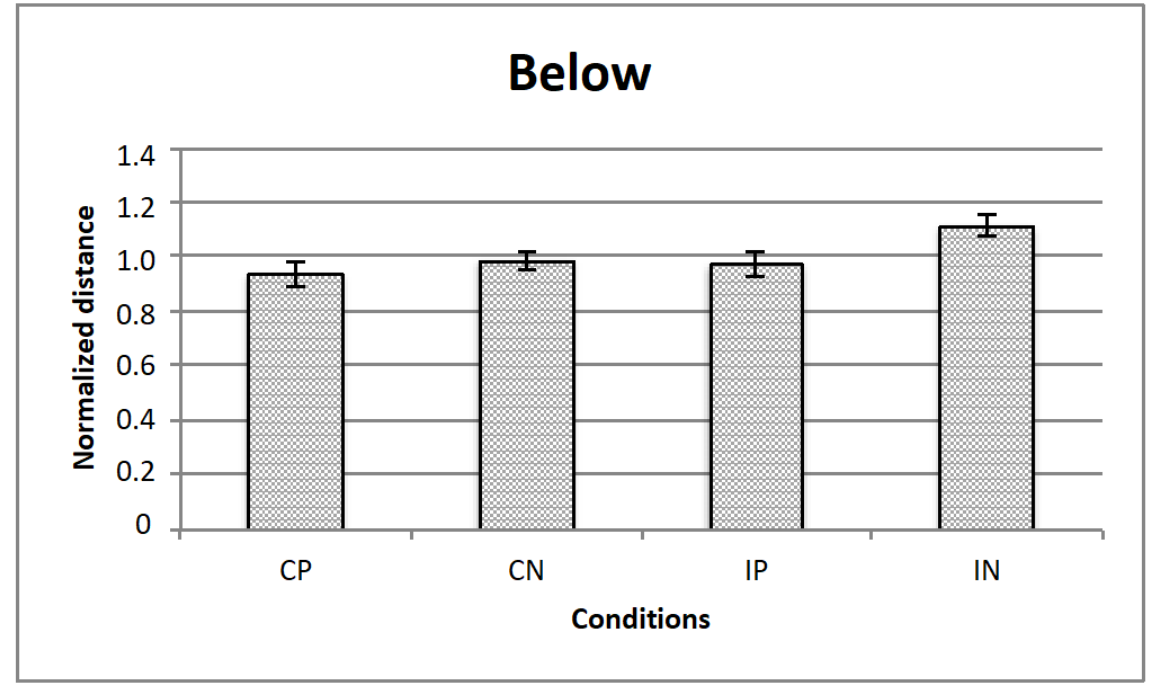
Figure 7. The figure represents the data for the illumination from below: The horizontal axis represents the experimental conditions (i.e., CP, CN, IP, IN), while the vertical axis is for the normalized critical distance (i.e., averaged across observers). Standard errors are reported.